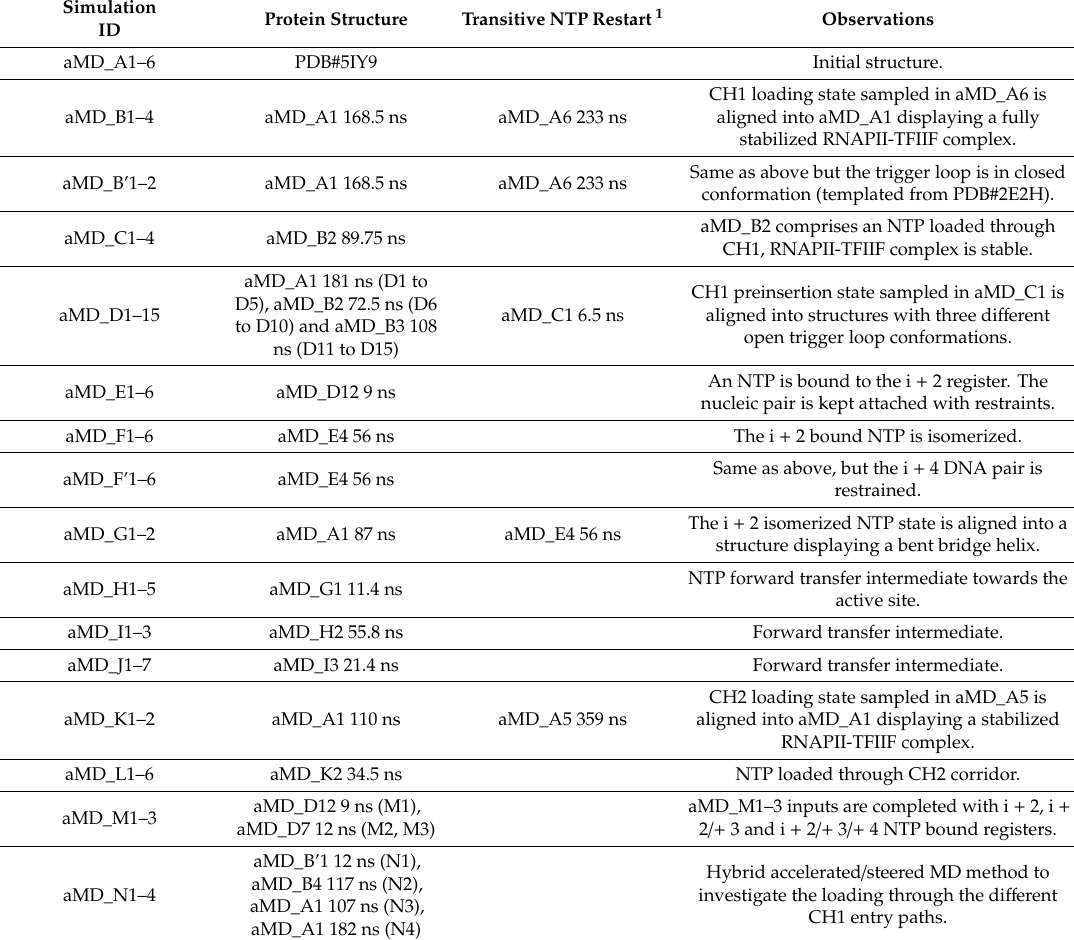
Table 1. Simulation